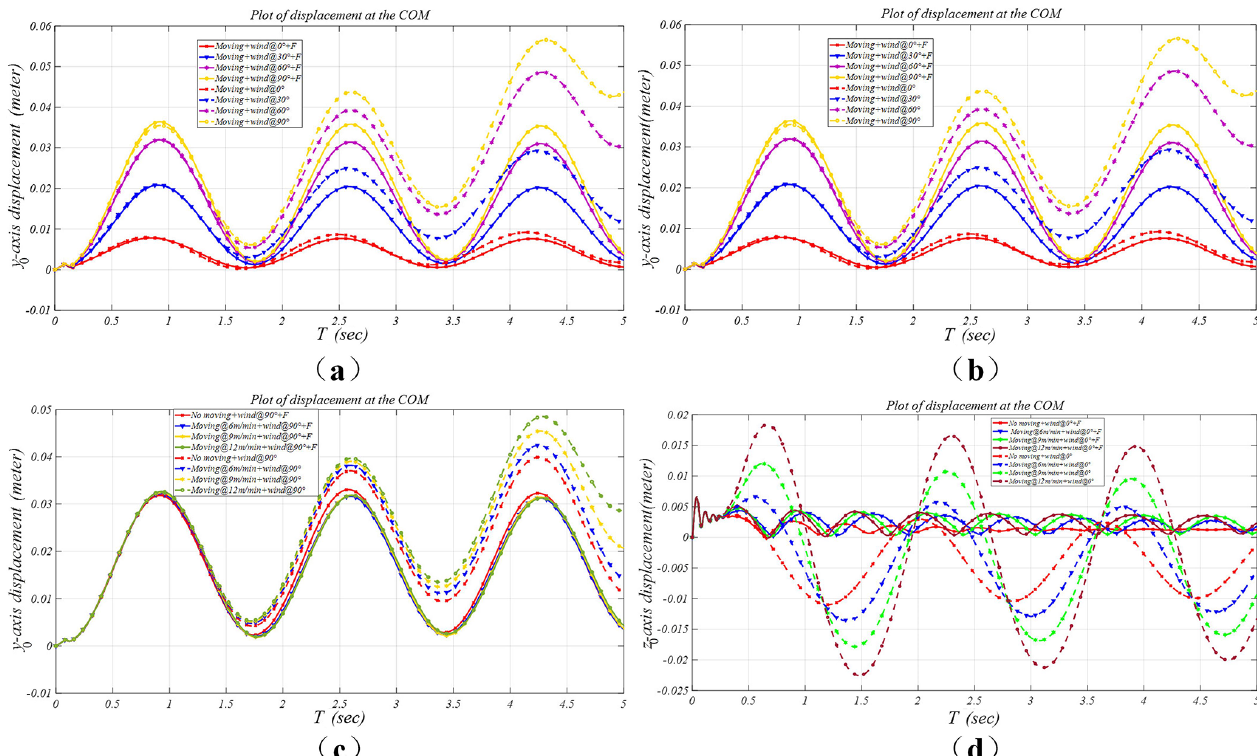
Figure 15. Swing displacement of the FPLIR’s COM. (a) The swing displacement of the FPLIR’s COM ( δ 0 ) along the y 0 axis at a different wind angle. (b) The swing displacement of the FPLIR’s COM ( δ 1 ) along the z 0 axis at a different wind angle. (c) The swing displacement of the FPLIR’s COM ( δ 0 ) along the y 0 axis at a different walking speed. (d) The swing displacement of the FPLIR’s COM ( δ 1 ) along the z 0 axis at a different walking